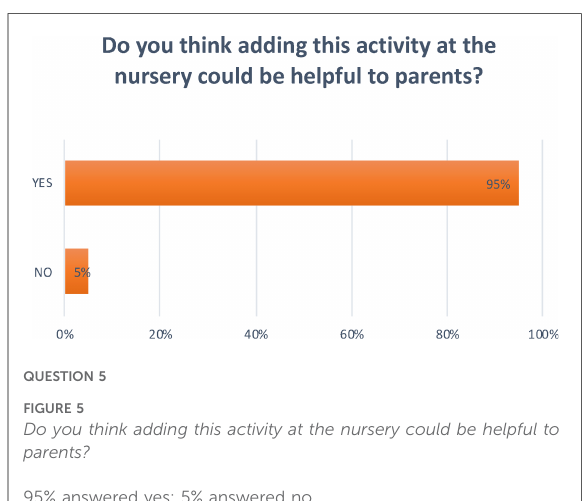
FIGURE 4 Do you think it would be useful to add this activity at the nursery? 80% answered yes; 20% answered no.